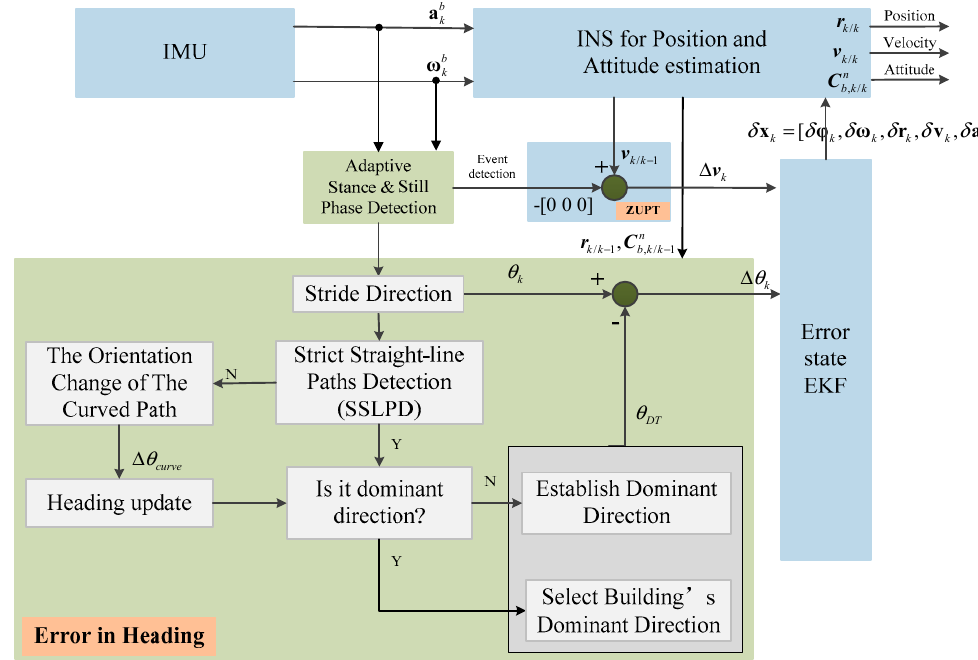
Figure 6. The enhanced Heuristic Drift Elimination (eHDE) algorithm mechanism.